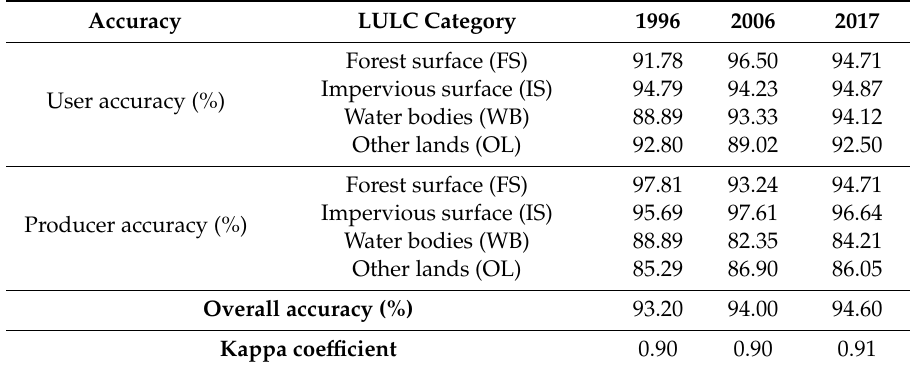
Table 2. Accuracies and kappa coe ffi cient of land use / land cover (LULC) classifications in the